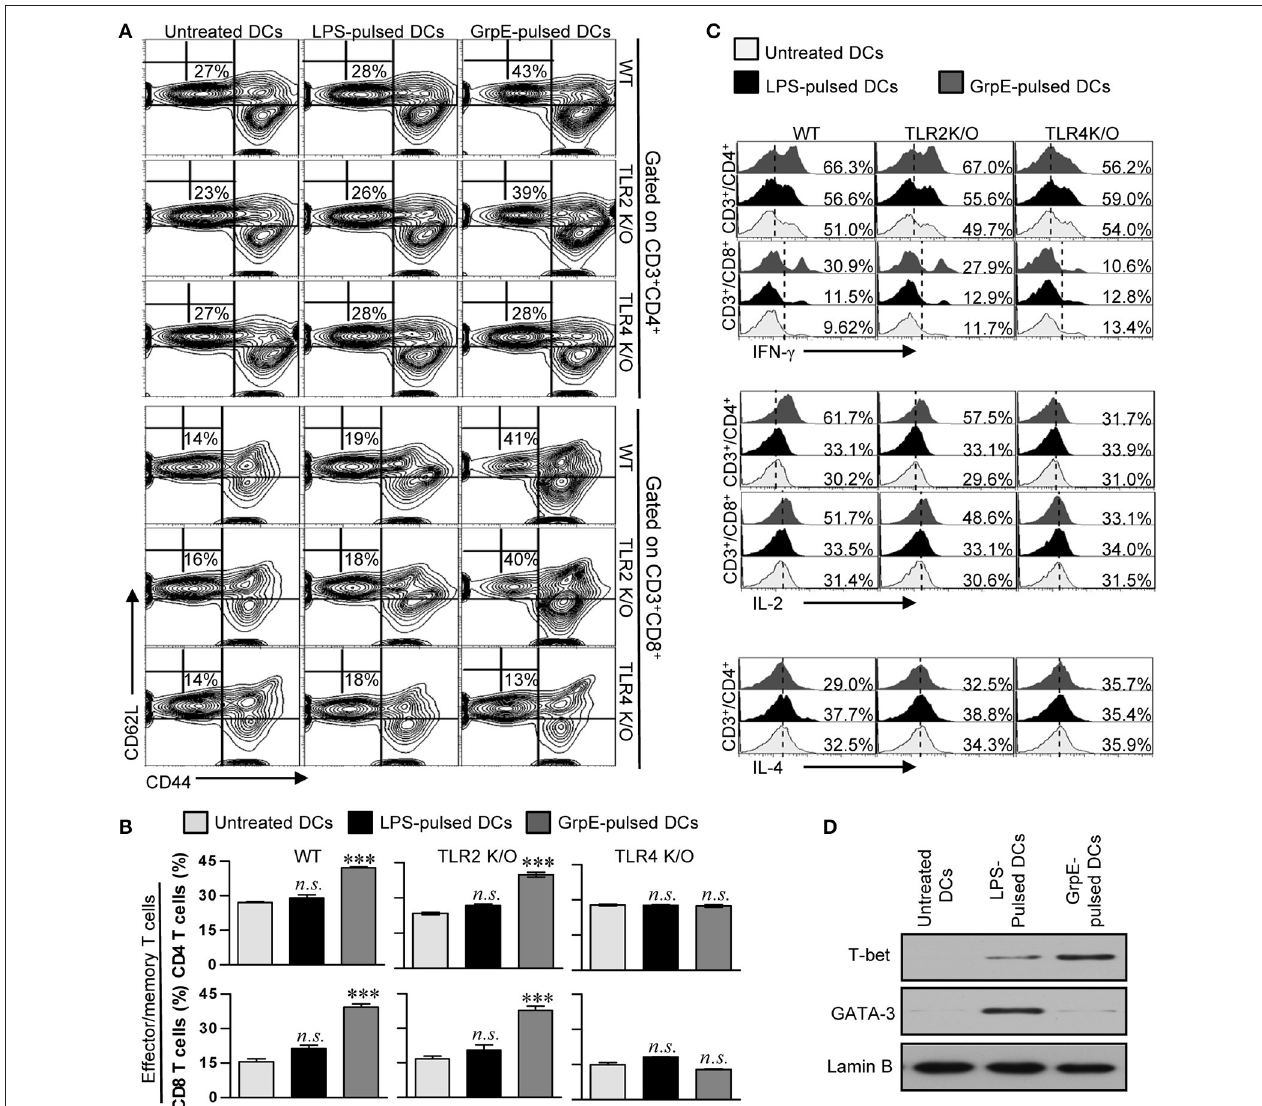
FIGURE 6 | Induction of the effector/memory T cell proliferation and a Th1 response by GrpE-activated DCs via TLR4-dependent DC maturation. (A , B) WT-, TLR2 K/O-, and TLR4 K/O-DCs were treated with 10 µ g/mL GrpE for 24h. The GrpE-treated DCs were washed and co-cultured with allogeneic T cells (splenocytes from BALB/c mice infected with Mtb H37Rv) at DC to T cell ratios of 1:10 for 3 days. T cells were stained with anti-CD4, anti-CD8, anti-CD62L, and anti-CD44 mAbs. Contour (A) and bar graphs (B) show CD62L + CD44 + T cells. (B) Bar graphs show the percentages (mean ± SD , n = 4 samples) for CD44 + CD62L − T cells from representative result of three independent experiments. Statistical significance (*** p < 0.001) is indicated for treatments compared to untreated DCs, and no significant effect is indicated as n.s. (C) After 12h of co-culture, IFN- γ , IL-2, and IL-4 expression levels in CD3 + CD4 + and CD3 + CD8 + cells were analyzed in T cells co-cultured with untreated DCs, GrpE-pulsed DCs, and LPS-pulsed DCs by intracellular staining for the presence of GolgiPlug. Results are representative of three independent experiments. (D) WT-DCs were cultured with GrpE stimulation for 24h. The GrpE-treated DCs were co-cultured for 3 days with splenic T cells from